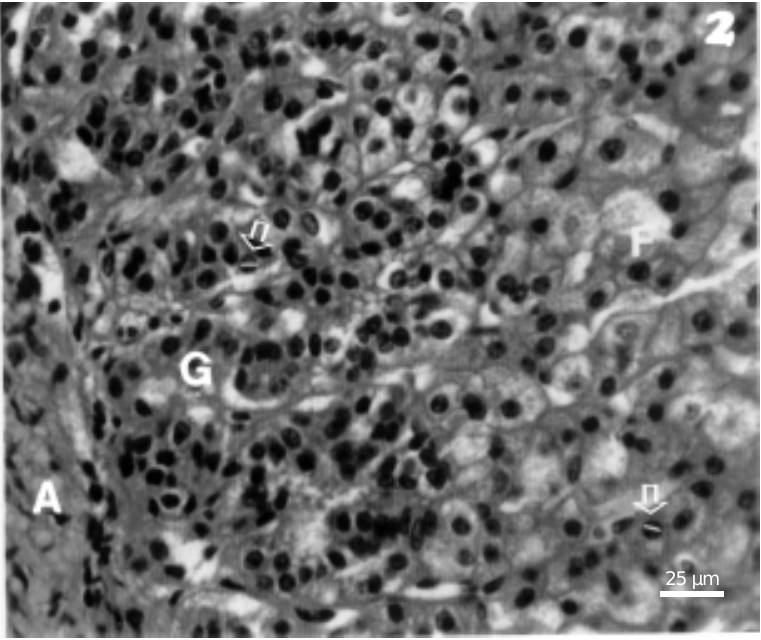
Figure 2 - Glomerulosa and fasciculata regions of a viscacha captured in August (winter). Capsule (A). The cells of the glomerulosa zone (G) at this time of year show pycnotic nuclei (arrow) where a reduction in nuclear diameter (line) can be observed. The fasciculata region (F) shows small cells with nuclei of condensed chromatin (arrow) and a reduced nuclear diameter (line) compared to that observed in March. H-E; 400X.